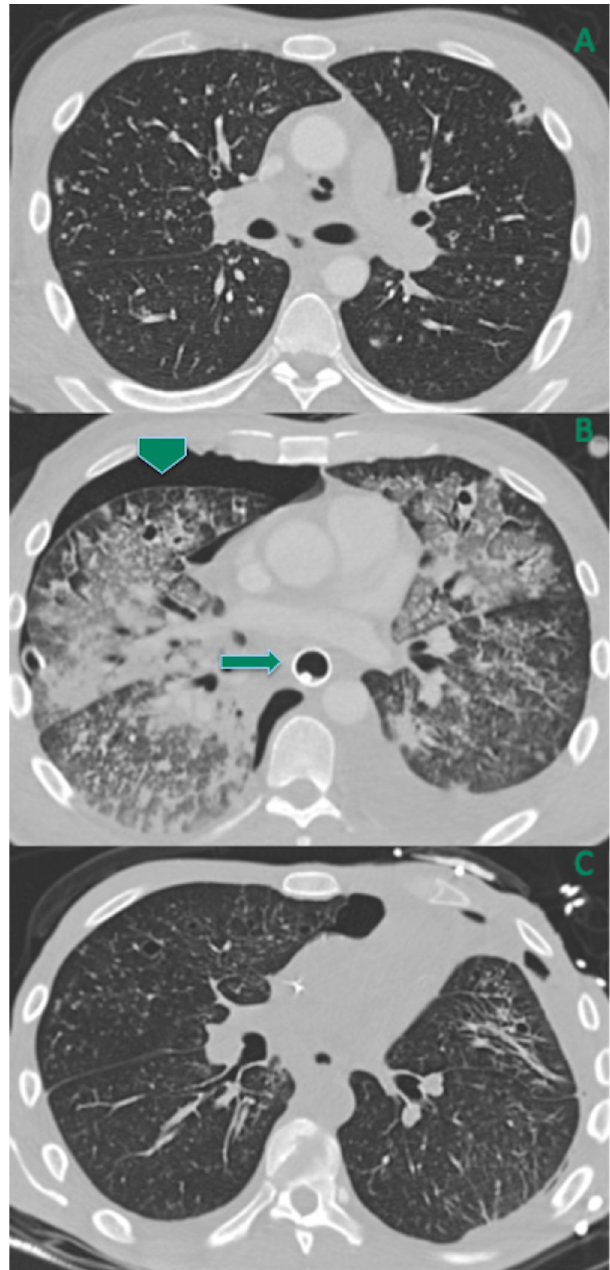
Figure 4. Sequential chest CT studies. ( A ) Multiple cavitary and non-cavitary lung nodules (same as Figure 3). ( B ) Hospital day 6: increased pulmonary tree-in-bud nodules and consolidations, new small right-sided pneumothorax (arrowhead), and new esophageal stent (arrow). ( C ) One month follow-up: nearly-resolved pulmonary opacities decreased tiny right pneumothorax, and removal of esophageal